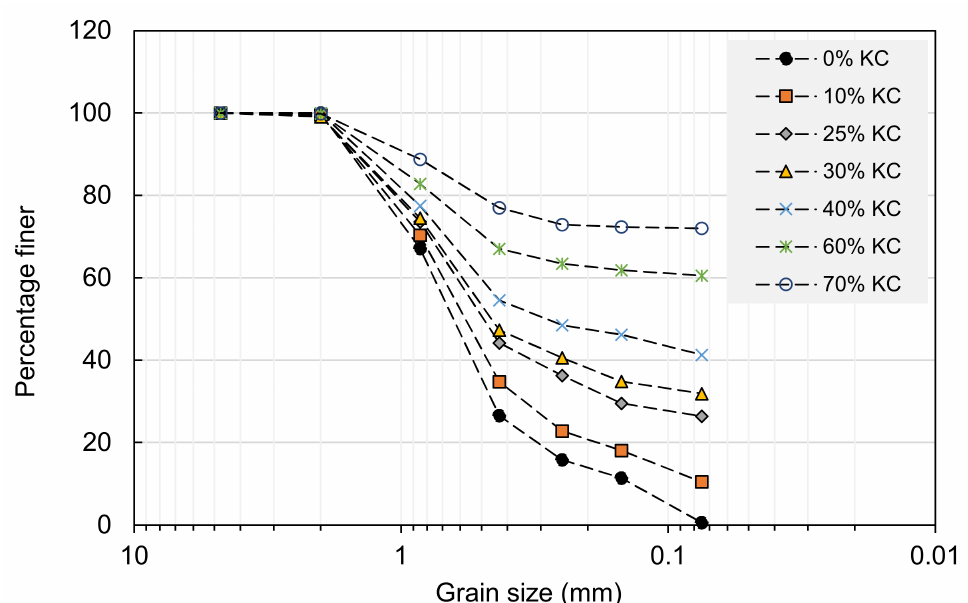
Figure 2. Gradation of sand–kaolinite mixtures according to fines content.